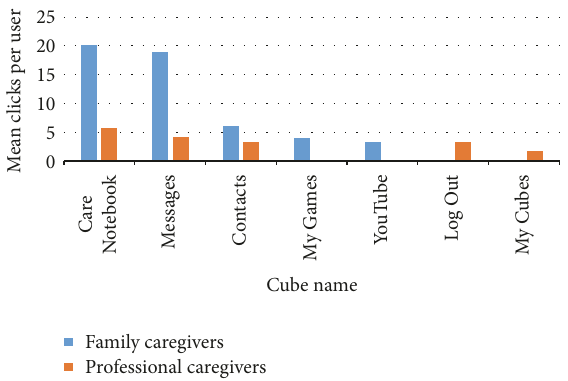
Figure 2: Mean clicks per user of the five most frequently used Cubes.